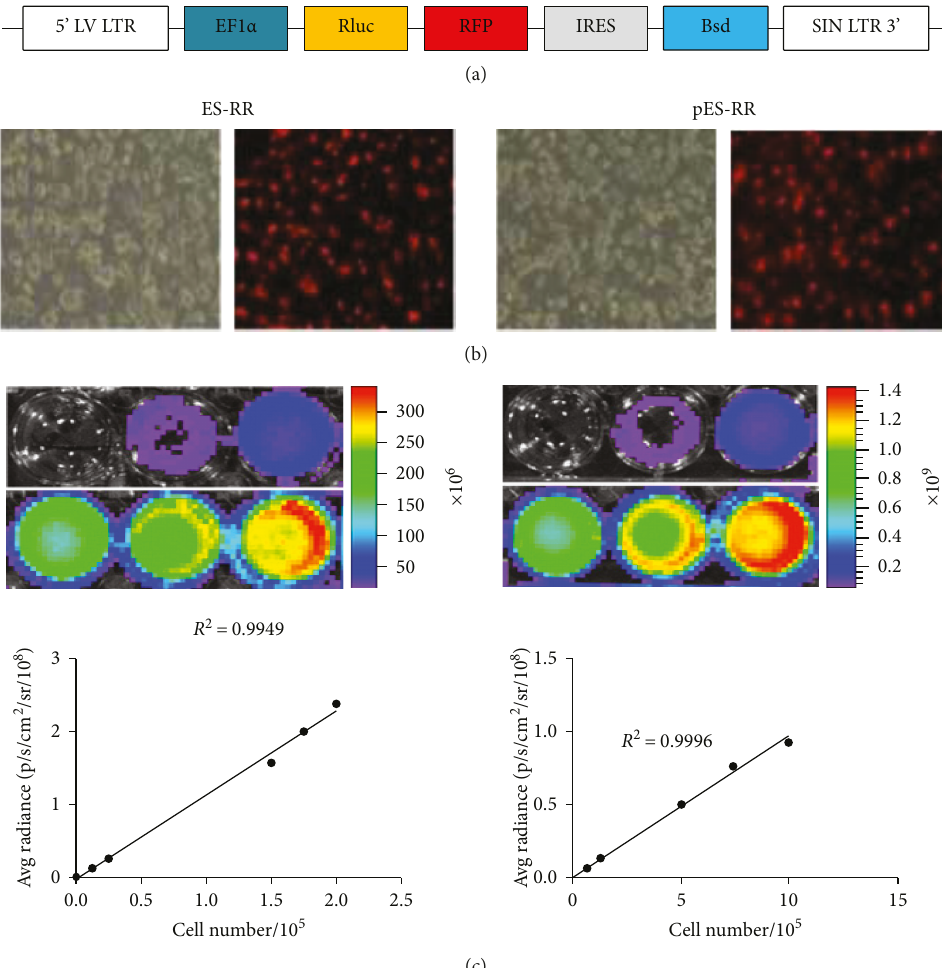
Figure 1: Generation of pES cells and ES cells labeled with double-fusion reporter genes. (a) Schema of lentiviral construct showing EF1 α promoter driving Rluc and RFP. (b) Bright fi eld and fl uorescence microscopy showing RFP expression in pES cells and ES cells. (c) BLI of pES cells and ES cells shows a robust correlation between cell number and Rluc